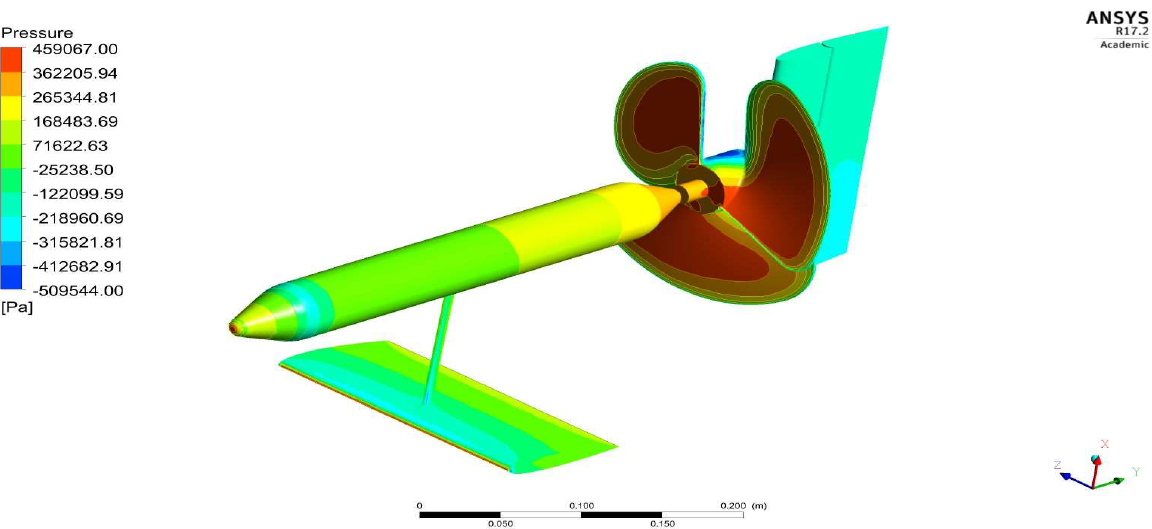
Figure 34. An isometric projection of pressure distributions on advanced US with horizontal fins—high speed altitude increment operation.